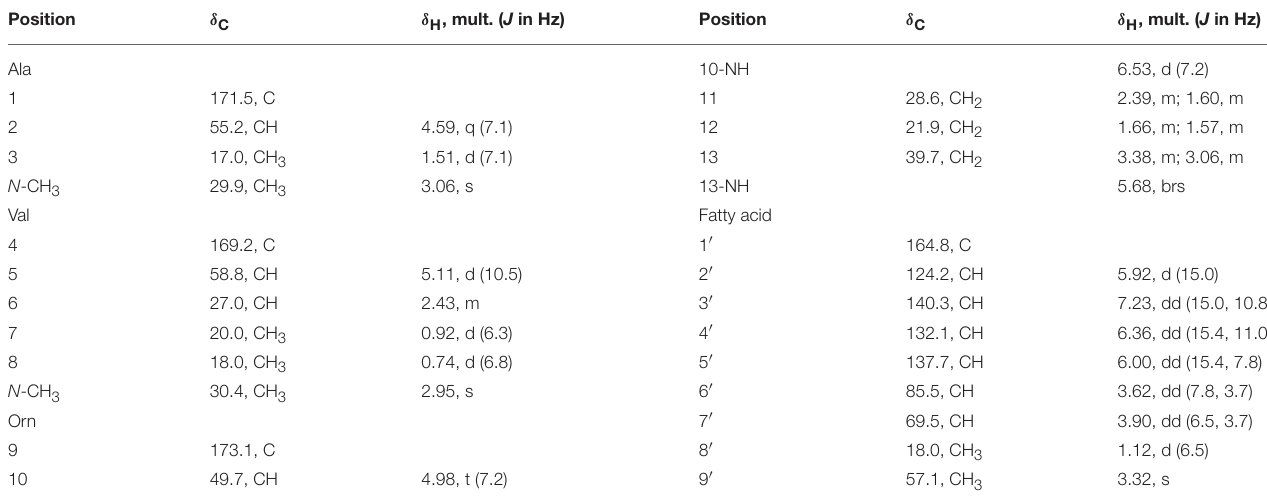
TABLE 2 | 1 H (600 MHz) and 13 C NMR (150 MHz) Data for 2 in CDCl 3 .